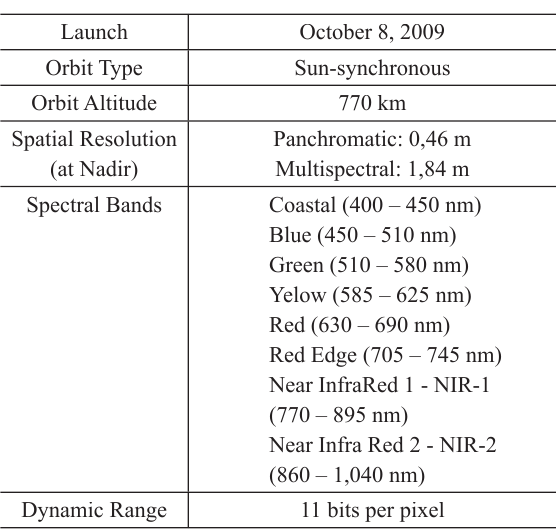
Worldview-2 system specifi